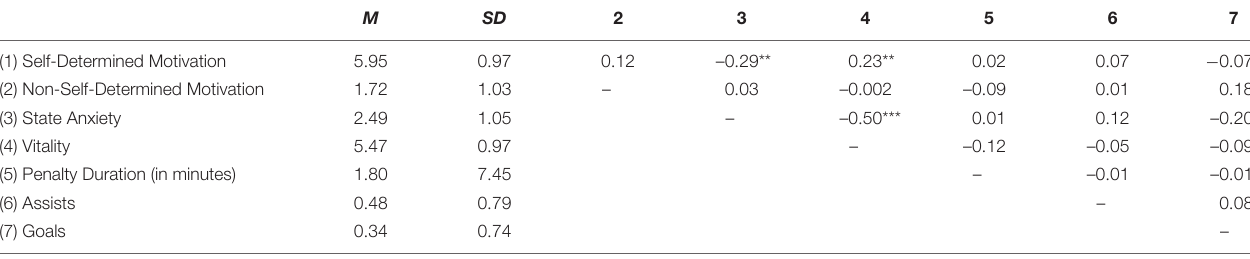
TABLE 1 | Bivariate correlations among the psychological variables and the on-ice behavioral measures. M SD